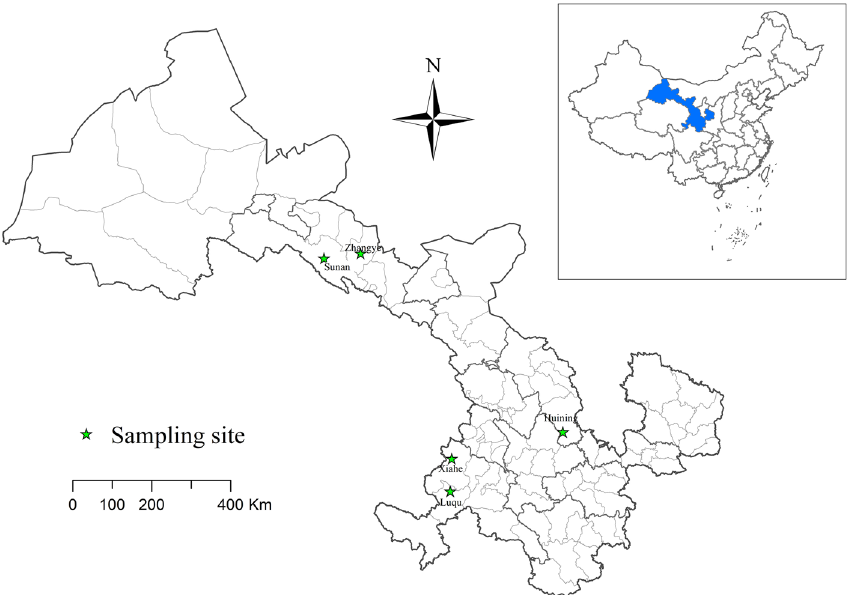
Figure 1. Distribution of five sampling sites from Gansu Province. The map was created with software ArcGIS version 10.0 (URL: https:// www. esri.